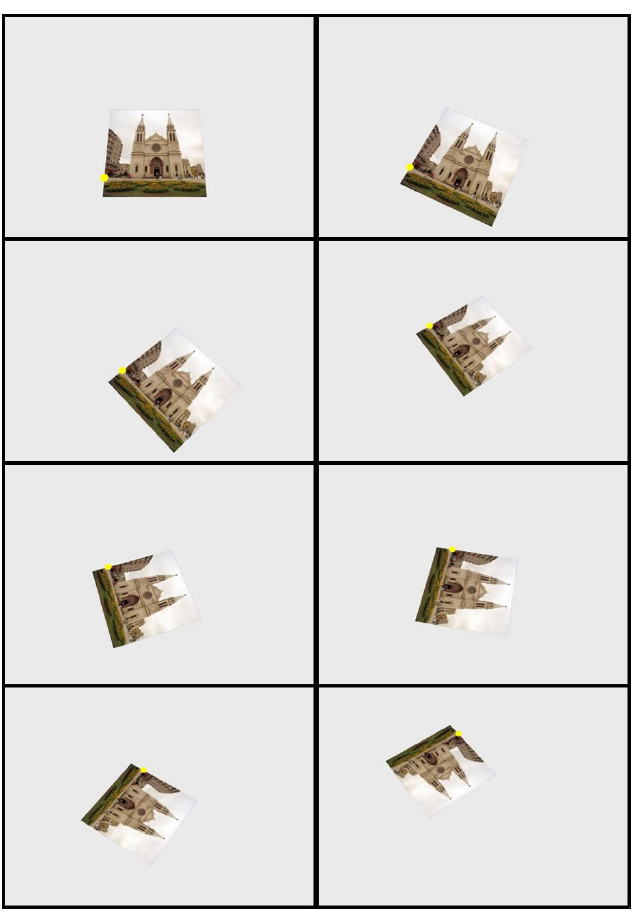
Figure 10. Frames captured by the First Person View mode. This visualization recovers the user view from camera pose.